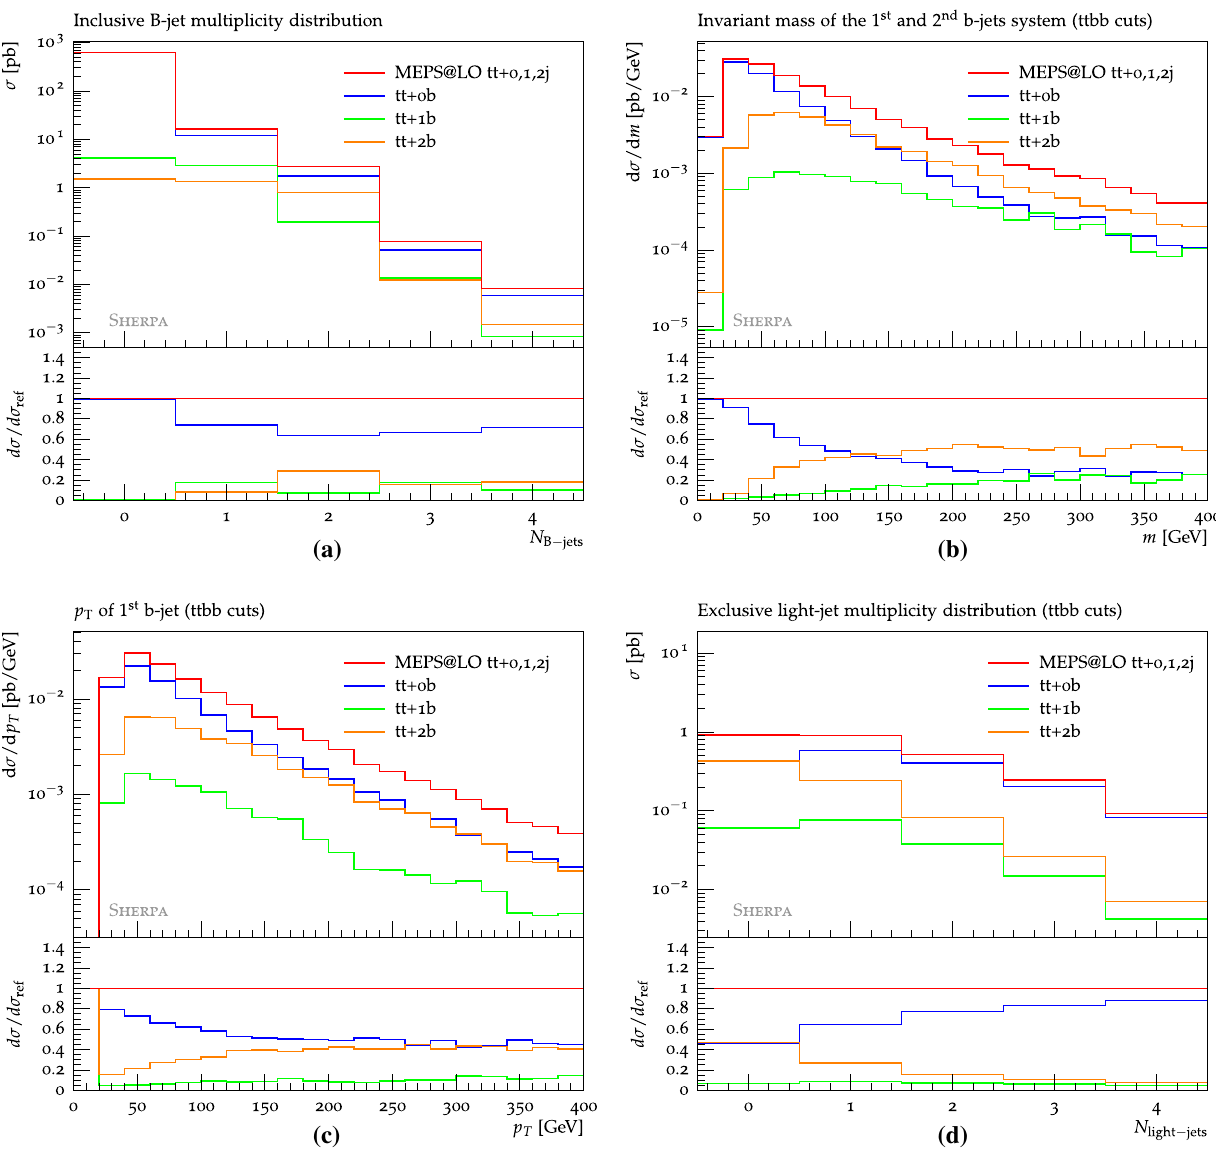
Fig. 4 Breakdown of merged LOPS simulations of t ¯ t + 0 , 1 , 2jets production at 13TeV into the contributions from matrix elements with t ¯ t + 0,1 and 2 b -quarks. Same observables a – c as in Fig. 3 and distribution in the exclusive number of light jets with p T > 25GeV ( d ) in the presence of ttbb